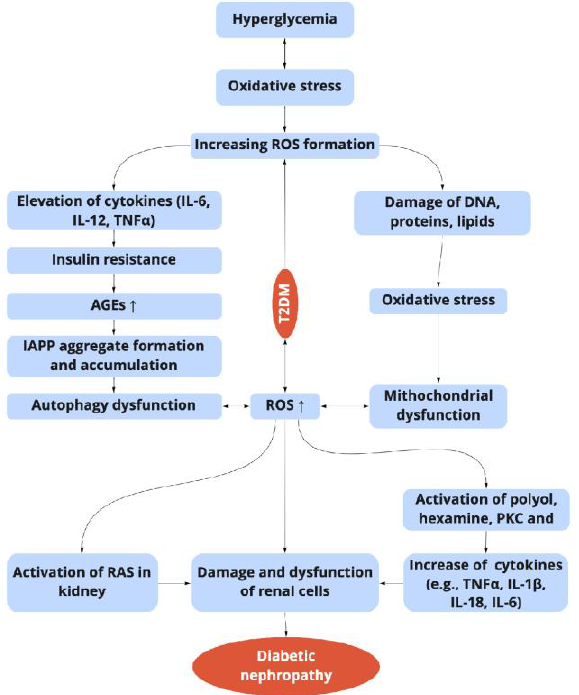
Figure 2. Relationship between the hyperglycemia-induced oxidative stress, inflammation, and diabetic nephropathy in T2DM. ROS: reactive oxygen species; TNF- α : tumor necrosis factor- α ; NF- κ B: nuclear transcription factor- κ B; AGEs: advanced glycation end products; PKC: protein kinase; IAPP: islet amyloid polypeptide; RAS: renin-angiotensin system.